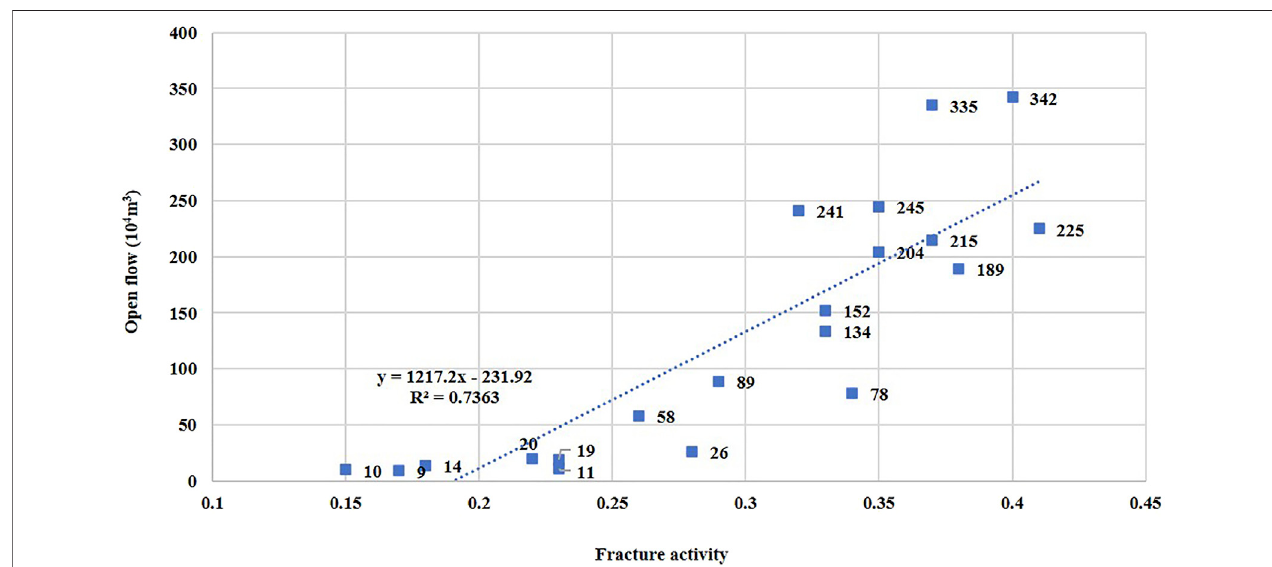
FIGURE 7 | The relationship between fracture activity and open fl ow, the horizontal axis is fracture activity, and the vertical axis is open fl ow of gas well.